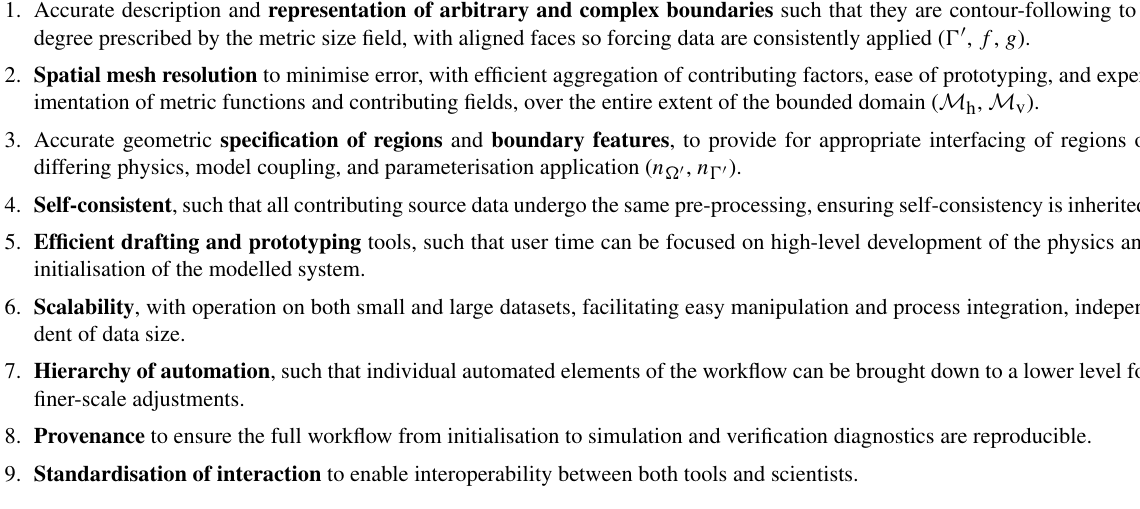
Table 1. The nine tenets of geophysical mesh generation that solutions to the spatial discretisation of geophysical model domains should address (from Candy,